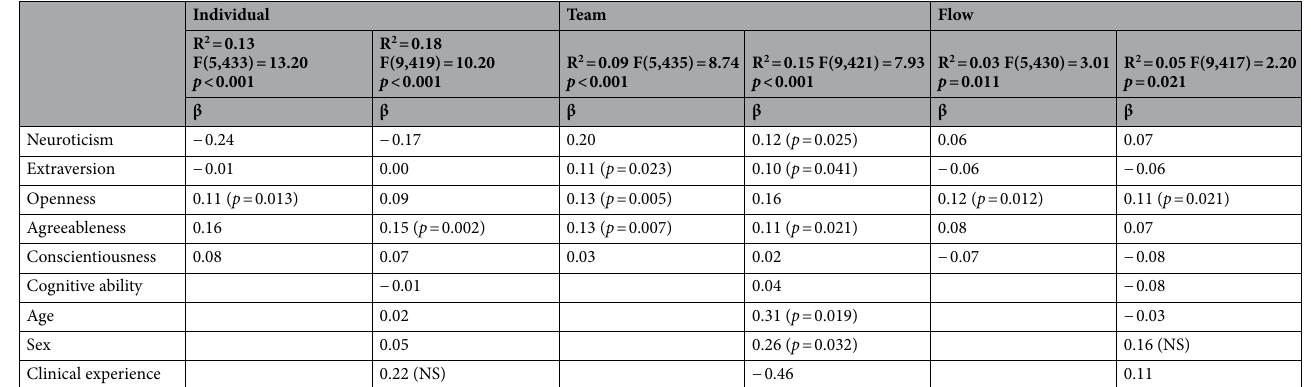
Table 4. Regression models: the effects of personality traits on the decision-making styles. SE Standard error (0.00–0.08), β = standardized estimate. All estimates above 0.15 are significant p < 0.001, except when specified otherwise. Men = 0, Women =